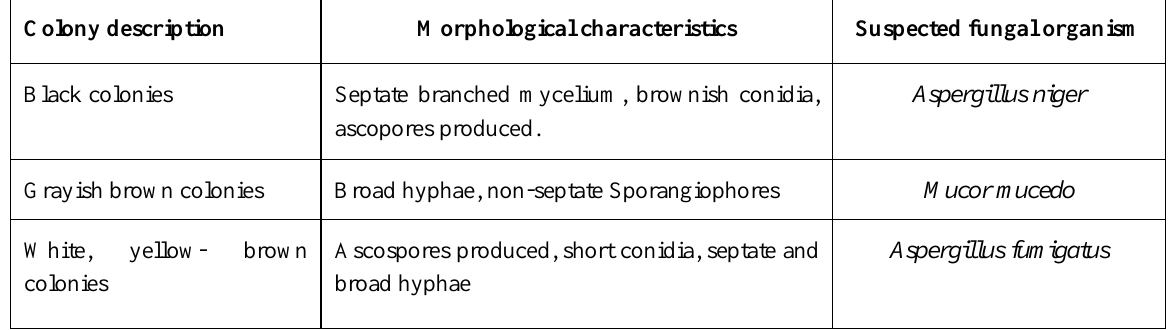
Table 3. Morphological description of fungal isolates.